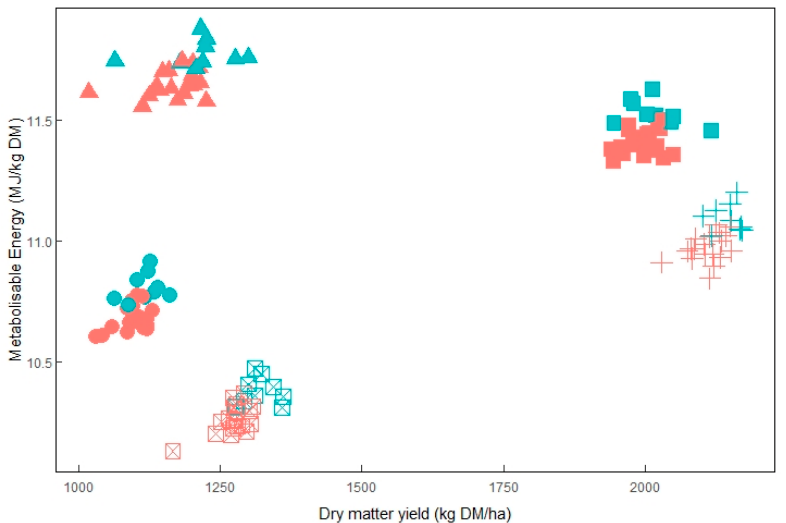
Figure 4. Relationship between metabolisable energy (ME, MJ/kg DM) and individual harvest dry matter (DM) yields (kg DM/ha) of candidates grouped by seasonal period: autumn ( • ), winter ( (cid:78) ), early spring ( (cid:4) ), late spring (+), summer ( (cid:2) ) and ploidy: diploid ( • ), tetraploid ( • ). Each point on the graph combines the seasonal best linear unbiased prediction (BLUP) for DM yield and ME derived from 3 years of data and where all 4 trial sites were